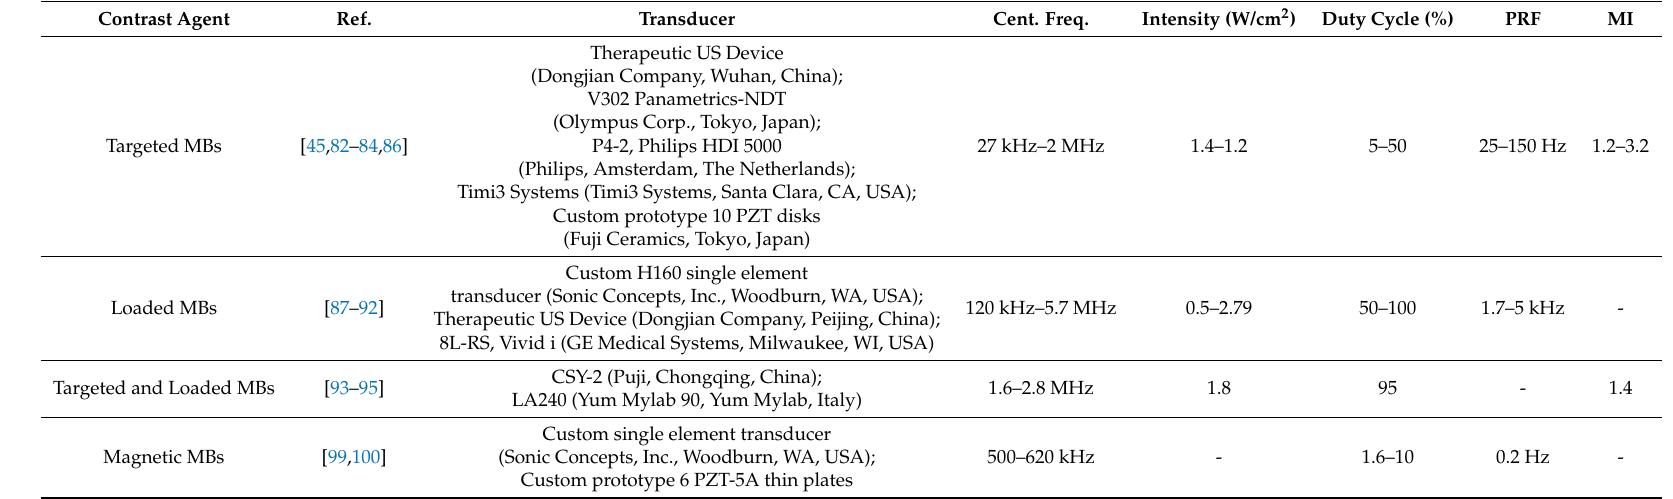
Table 1. Ultrasound parameters for novel contrast